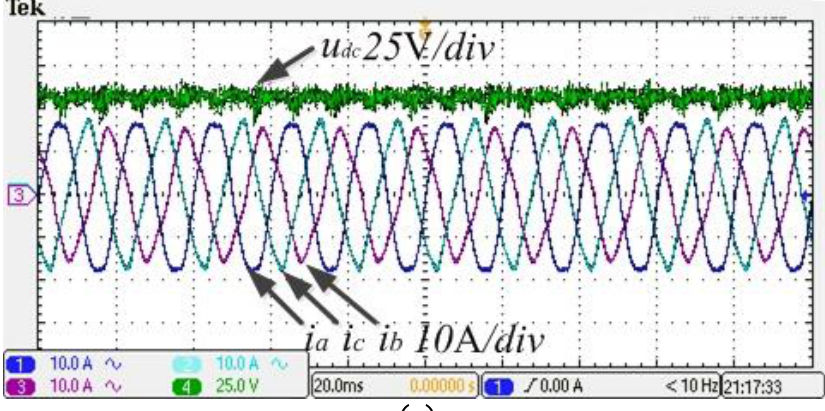
Figure 10. Waves of PIR regulator for DC link voltage: ( a ) waves of DC link voltage and unbalanced three-phase current; ( b ) waves of UC current with and PWM driver of